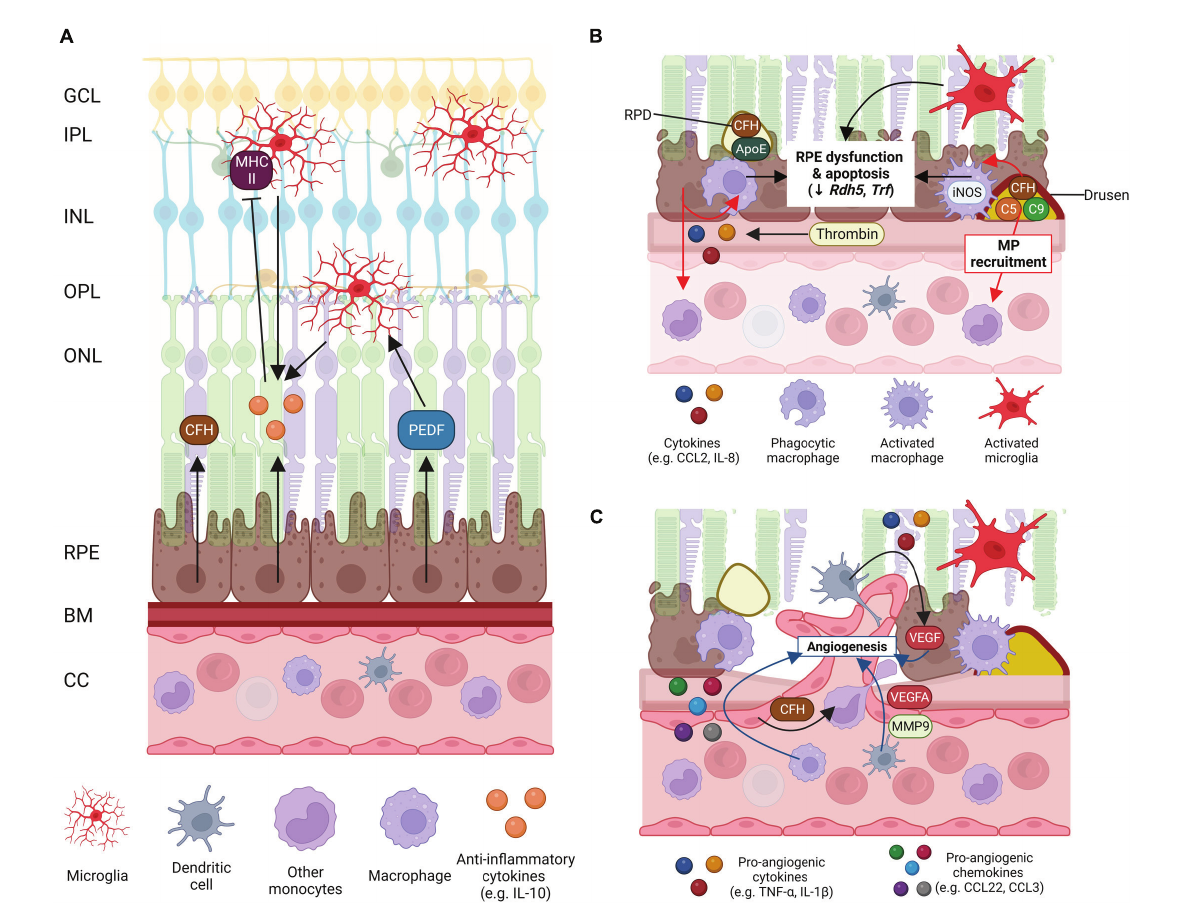
FIGURE3 Schematic of mononuclear phagocyte (MP) interactions with the ocular tissues in health eyes and late-stage age-related macular degeneration (AMD). (A) Healthy posterior eye, showing transverse section of the retinal layers, the retinal pigment epithelium (RPE), Bruch’s membrane (BM), and vascular supply (the choriocapillaris, CC). The location of the mononuclear phagocytes (MPs) is indicated including retinal tissue resident microglia associated with the neuronal synaptic layers (nerve fiber layer MPs not shown) and MPs in the choroid, including dendritic cells, macrophages and other monocytes. RPE expression of immunosuppressive cytokines (e.g., IL-10), growth factors (e.g., PEDF) and immune factors (e.g., CFH) are shown. (B) Schematic of late-stage AMD, geographic atrophy, showing loss of photoreceptors and RPE cells, and deposition of large drusen. The RPE expresses chemokines, e.g., CCL-2 and IL-8 to recruit immune cells to areas of damage. Microglia within the retina are activated, recruited to damaged RPE cells and RPD and activated iNOS-positive macrophages on the choroidal side are associated with the damaged RPE and drusen containing immunogenic complement pathway factors. Activated MP interaction with the RPE can contribute to RPE dysfunction and apoptosis. (C) Schematic of late-stage neovascular AMD showing choroidal neovascularization (CNV), loss of photoreceptors and RPE cells, and deposition of large drusen. Microglia within the retina are activated. Peripheral circulating MPs, dendritic cells are activated and associated with damaged RPE releasing VEGF and MMP-9 to drive new vessel development and are also able to enter the retina via new leaky vessels. There is an increase in expression of pro-inflammatory chemokines and cytokines by MPs and the RPE which drives angiogenesis and contributes to RPE cell dysfunction and death. Some of this illustration was started from a BioRender Template and content and stylistic modifications were